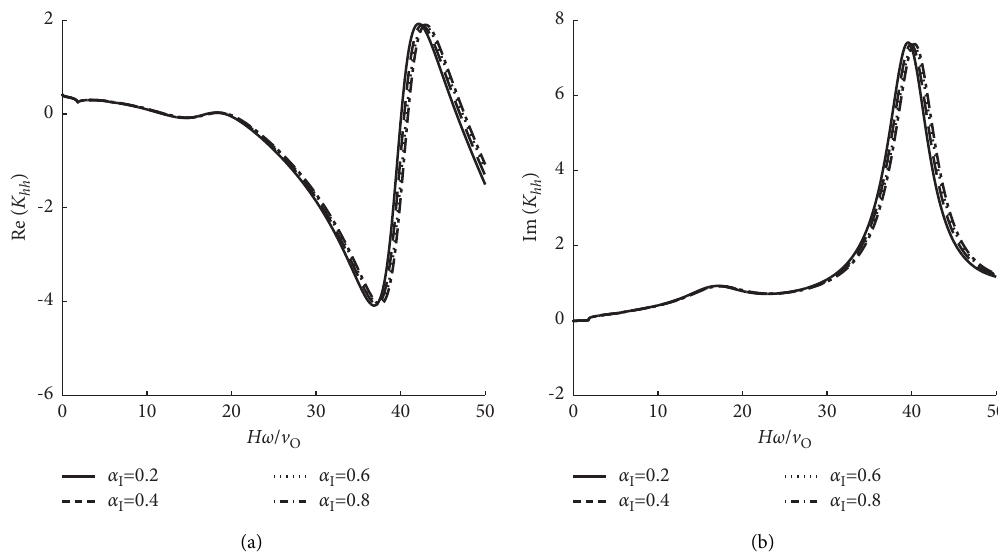
Figure 13: The horizontal dynamic impedance curves of pipe pile under different orders of fractional derivative viscoelastic model of the pile core soil. (a) Real part of horizontal dynamic impedance. (b) Imaginary part of horizontal dynamic impedance.